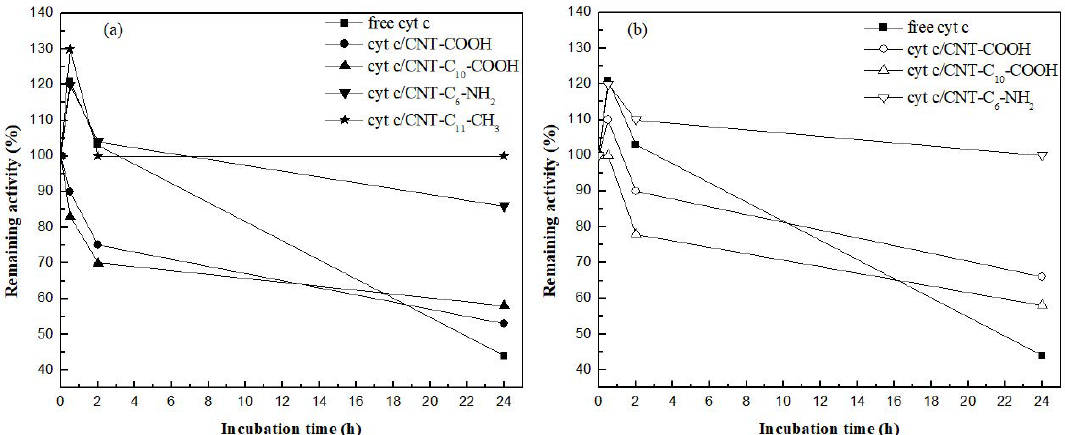
Fig. 2. Stability of free and (a) non covalently and (b) covalently immobilized cyt c on f-MWCNTs, after incubation at 40 o C with guaiacol. As 100% is indicated the peroxidase activity of cyt c at t = 0 min.